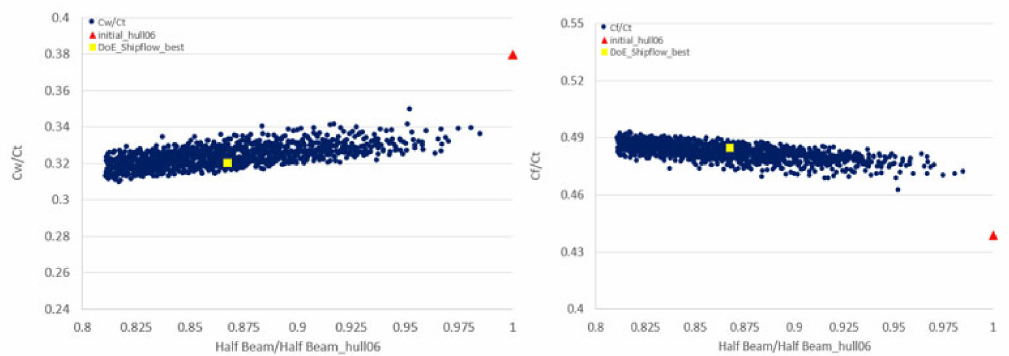
Figure 10. Percentage of wave C W (up) and frictional C f (down) to total C t resistance coe ffi cient for 30 m catamaran at 23 knots (850 parametrically generated designs, square symbol: best without beam constraint, triangle symbol: best with beam constraint).